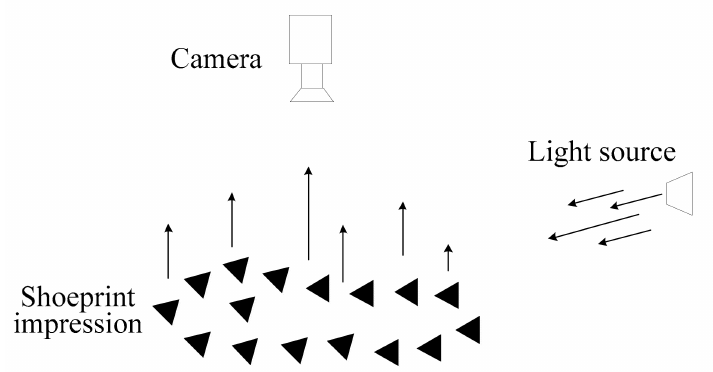
Figure 3. The imaging process of the crime scene shoeprints.